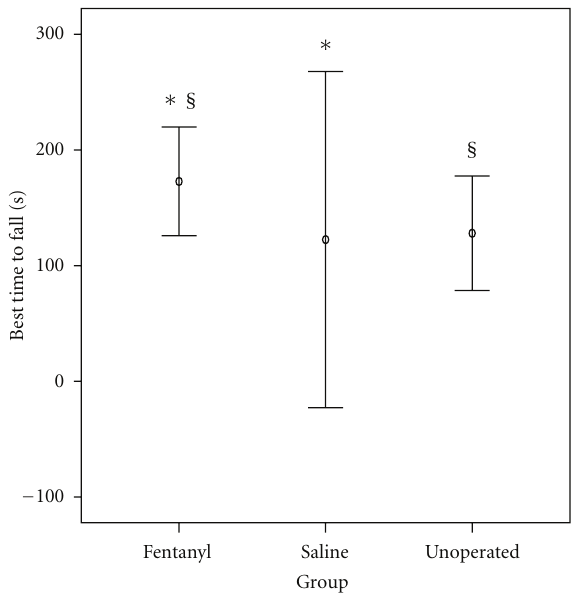
Figure 7: Best latency time to fall from the accelerating rotarod (speed 5–40 rpm). Rats administered fentanyl spent significantly more time on rod, compared to rats administered saline ( ∗ P = 0 . 022) or unoperated sham rats ( § P = 0 . 040). Values are mean ±